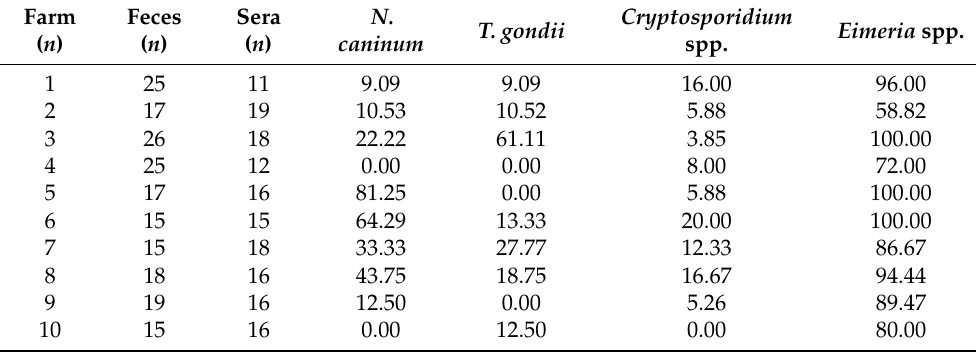
Table A1. Prevalence per farm of Apicomplexans parasites in Zapotillo Canton,